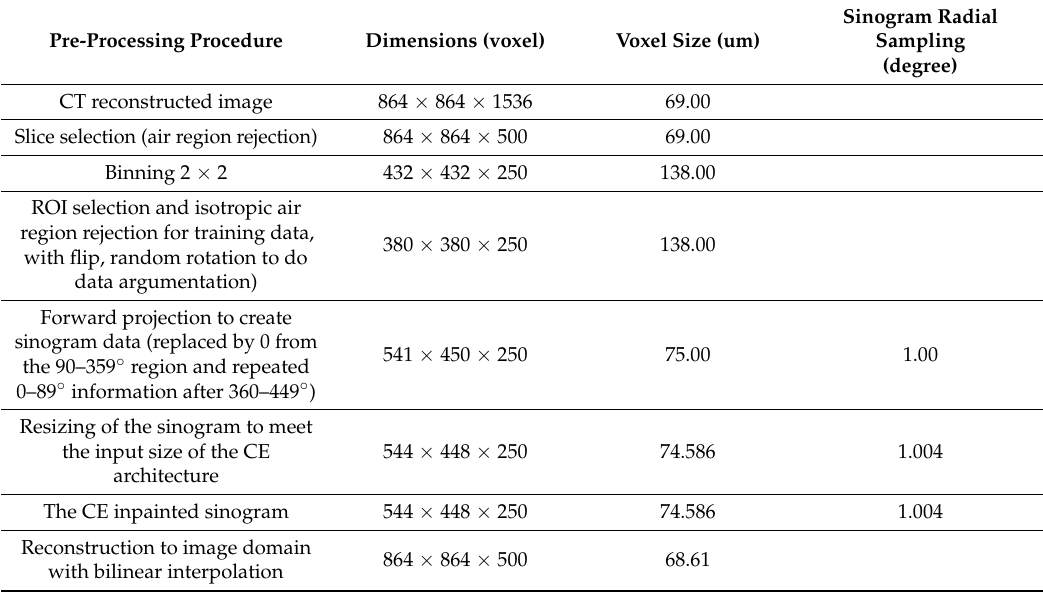
Table 2. Simulation methods of image pre-processing to manipulate the LA sinogram before CE inpainting on the MATLAB